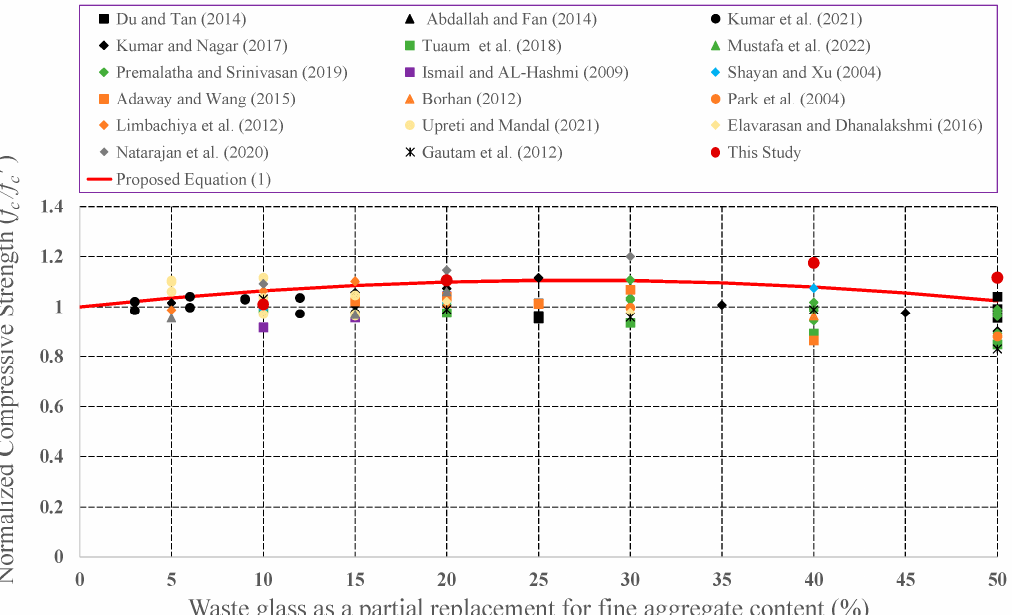
Figure 11. Discrepancy of the normalized CS of the concrete formed with CWG as a partial re ‐ placement for FA [28,33,44,46,58,63–67,69–74,77].